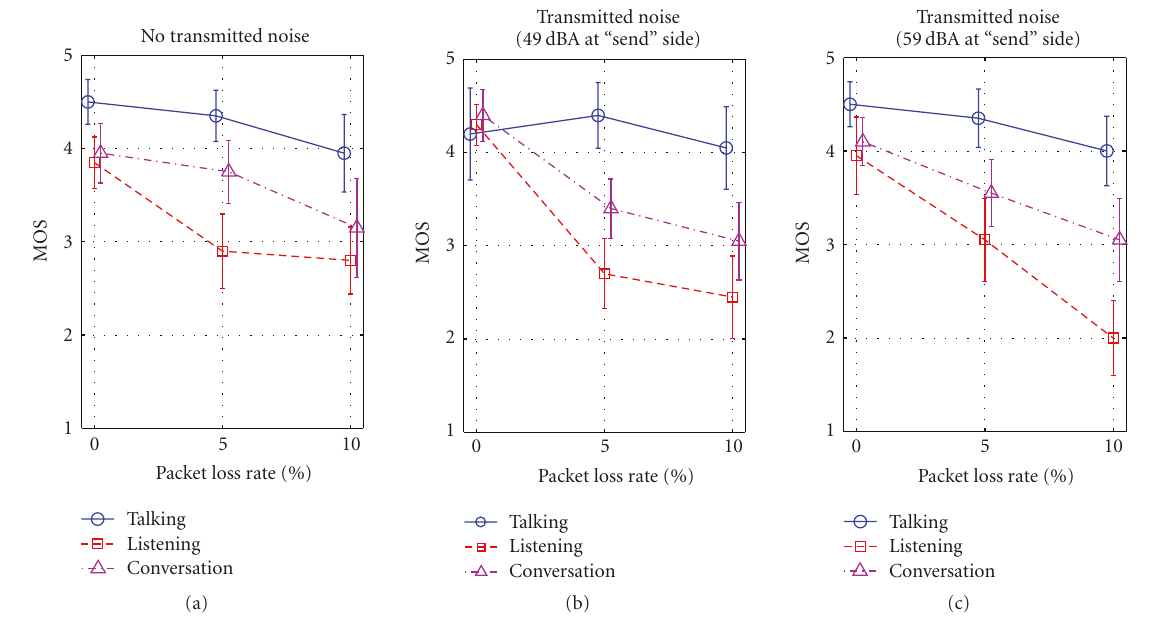
Figure 6: Packet loss and transmitted noise test